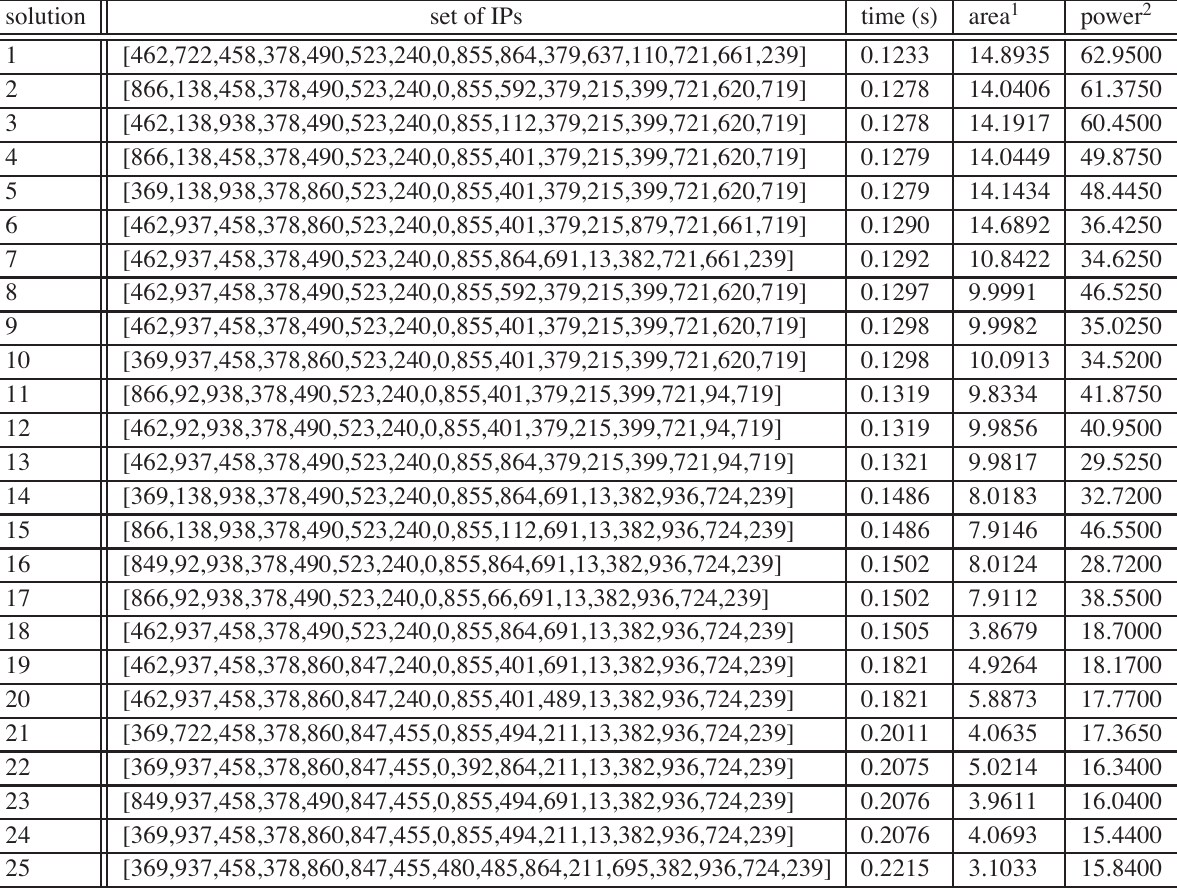
Fig. 8. Trade-off power × time for TG in Fig. 6 Table 2. Optimal IP assignment for the task graph of Fig.